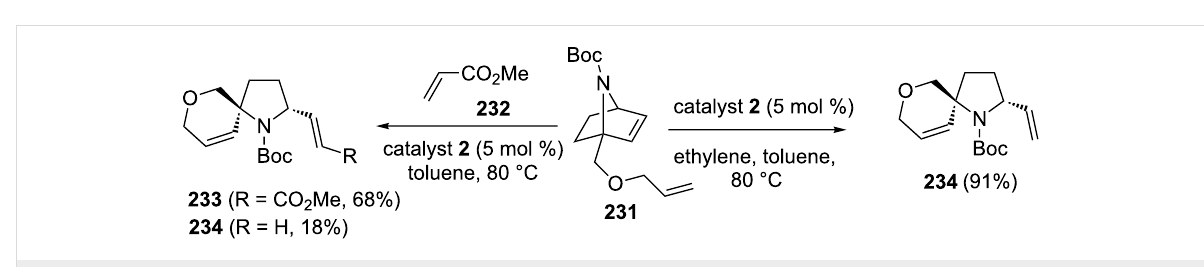
Scheme 47: RRM approach to spiro heterocyclic